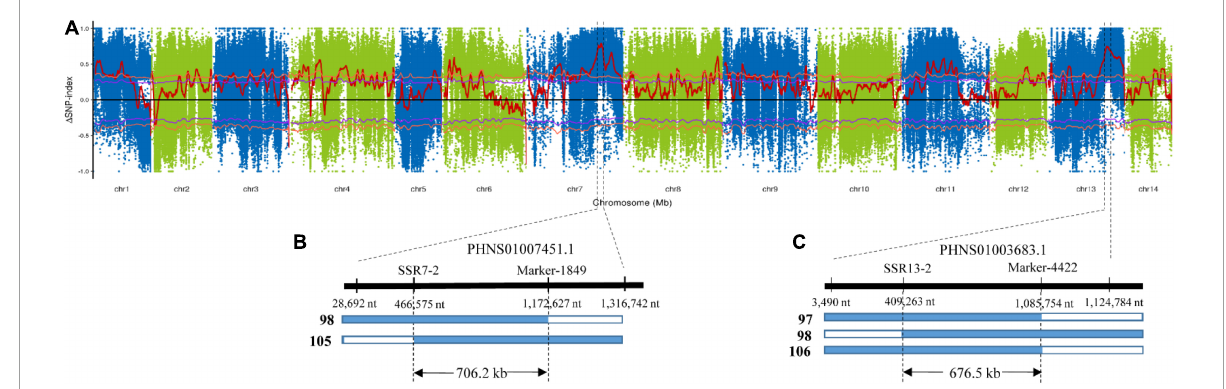
FIGURE3 Physical intervals of two major QTLs of crude fiber content, CF7 and CF13 . (A) (cid:49) SNP-index was calculated from the difference between the SNP-indexes of the pooled bulks. Red lines indicate the (cid:49) SNP-index. Purple and orange lines represent 95 and 99% confidence levels, respectively. In total, two and three recombinant individuals from 30 F 2 progenies with extremely low crude fiber content delimited the CF7 (B) and CF13 (C) into exact physical intervals, respectively. Other F 2 individuals with extremely low crude fiber content are not recombinant, and only tenacissima allele was observed in the corresponding QTL regions. Then, two outer numbers under the thick line represent the position of SNPs delimited the region of QTL from BSA, and the intermediated number under the thick line indicates the position of markers used for genotyping the recombinant